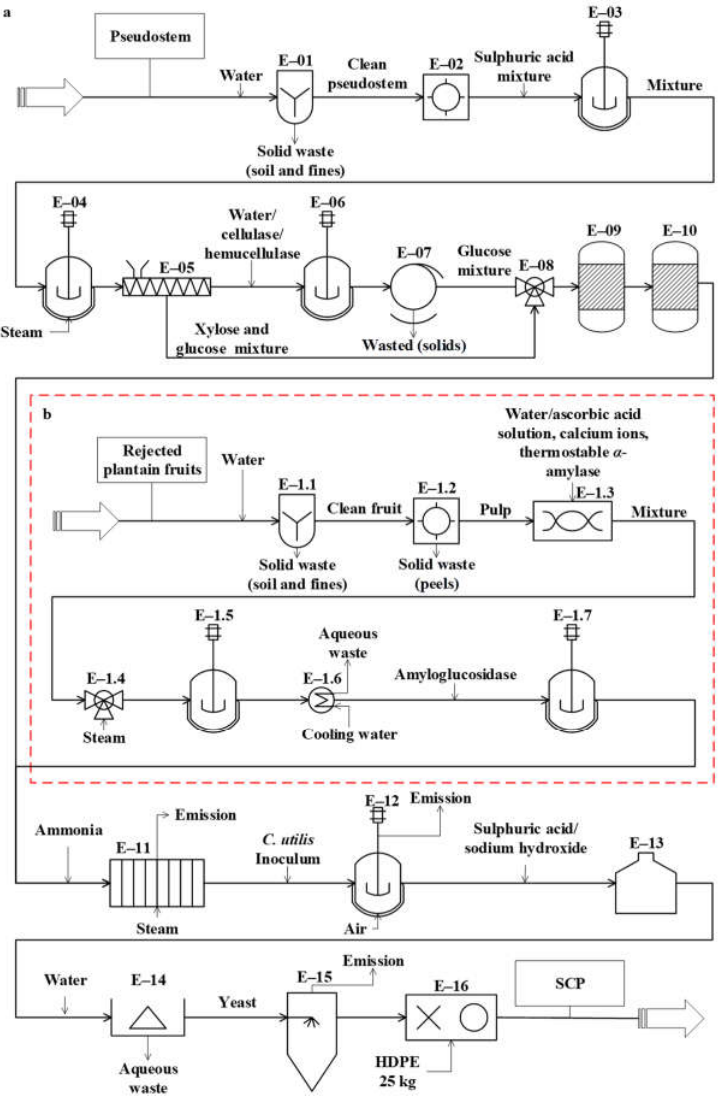
Figure 1. Diagram of the conceptual design for single-cell protein (SCP) production from ( a ) pseu- dostems and ( b ) rejected unripe plantain fruits.